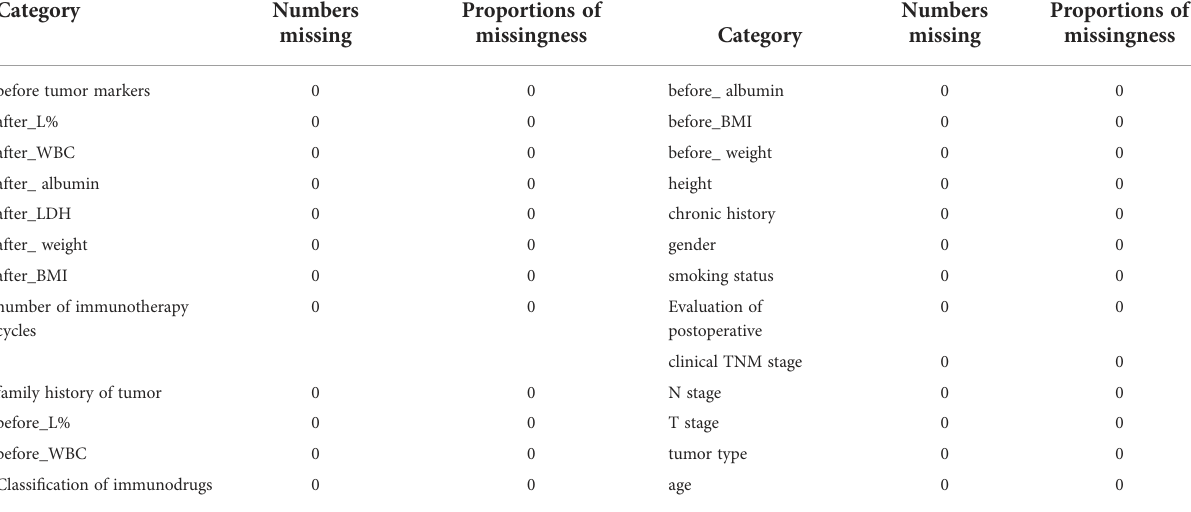
TABLE 3 Categories with no missing values in the collected clinicopathological data.